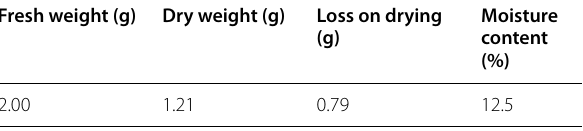
Table 4 Moisture content of B. pinnatum stem Fresh weight (g)